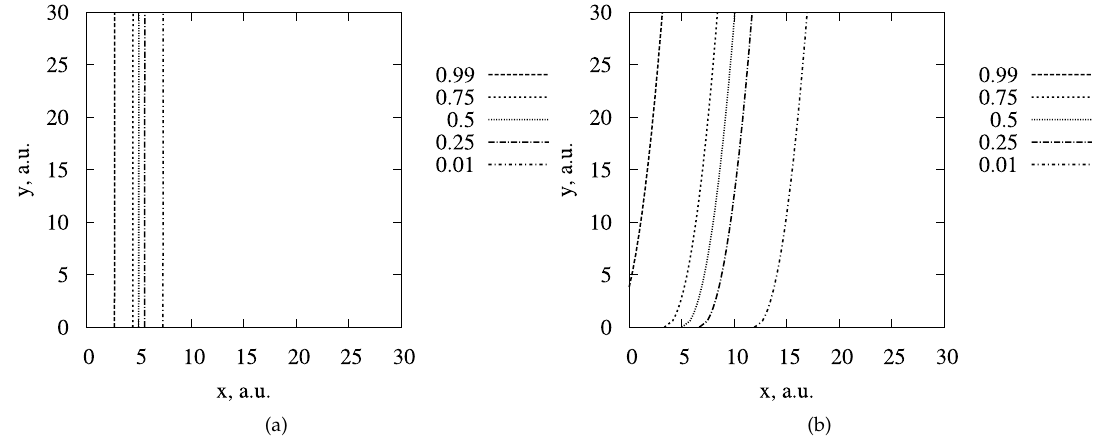
Figure 2. Contour plots of Merkuriev cut-off functions: ( a ) cut in 2-body configuration space; ( b ) cut in three-body configuration